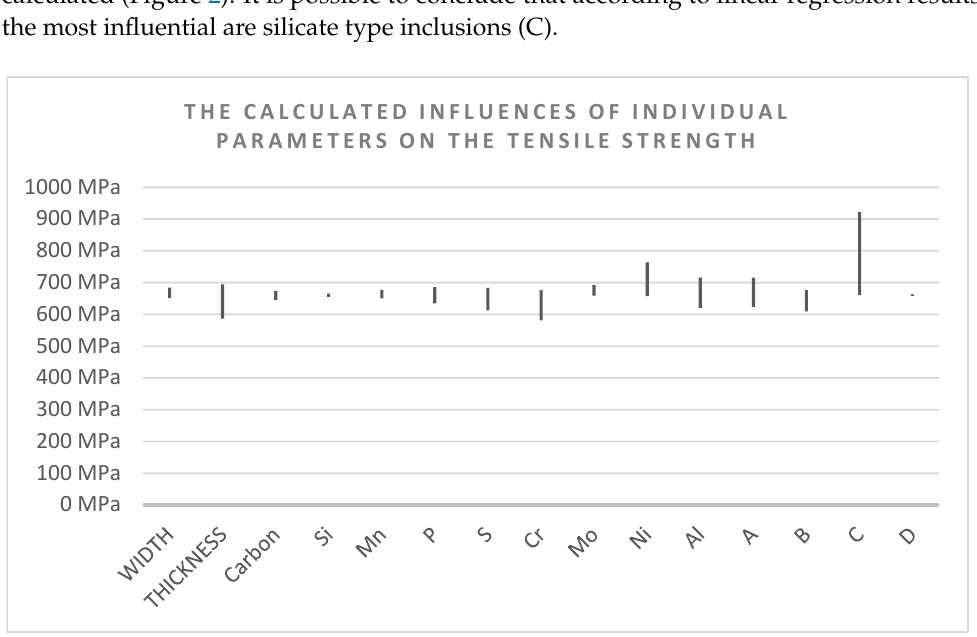
The average relative deviation from experimental data is